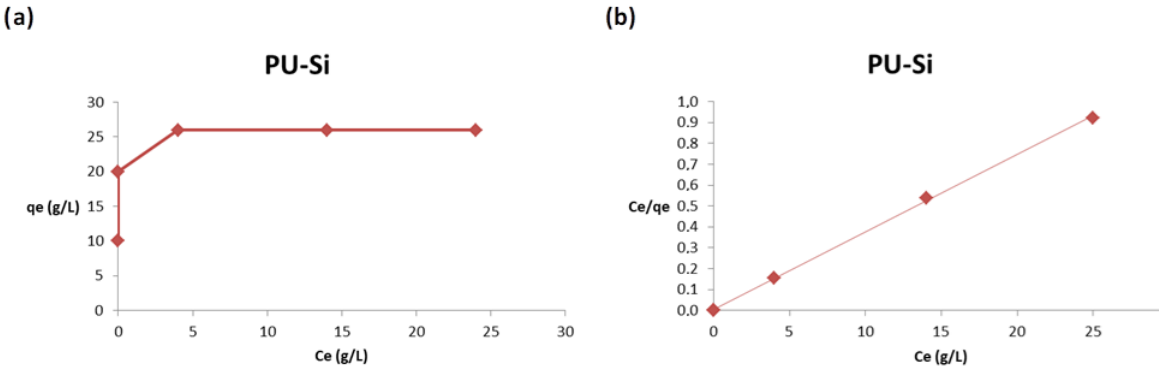
Figure 9. ( a ) Effect of the initial concentration on the adsorption capacity, q, ( b ) Langmuir plot.